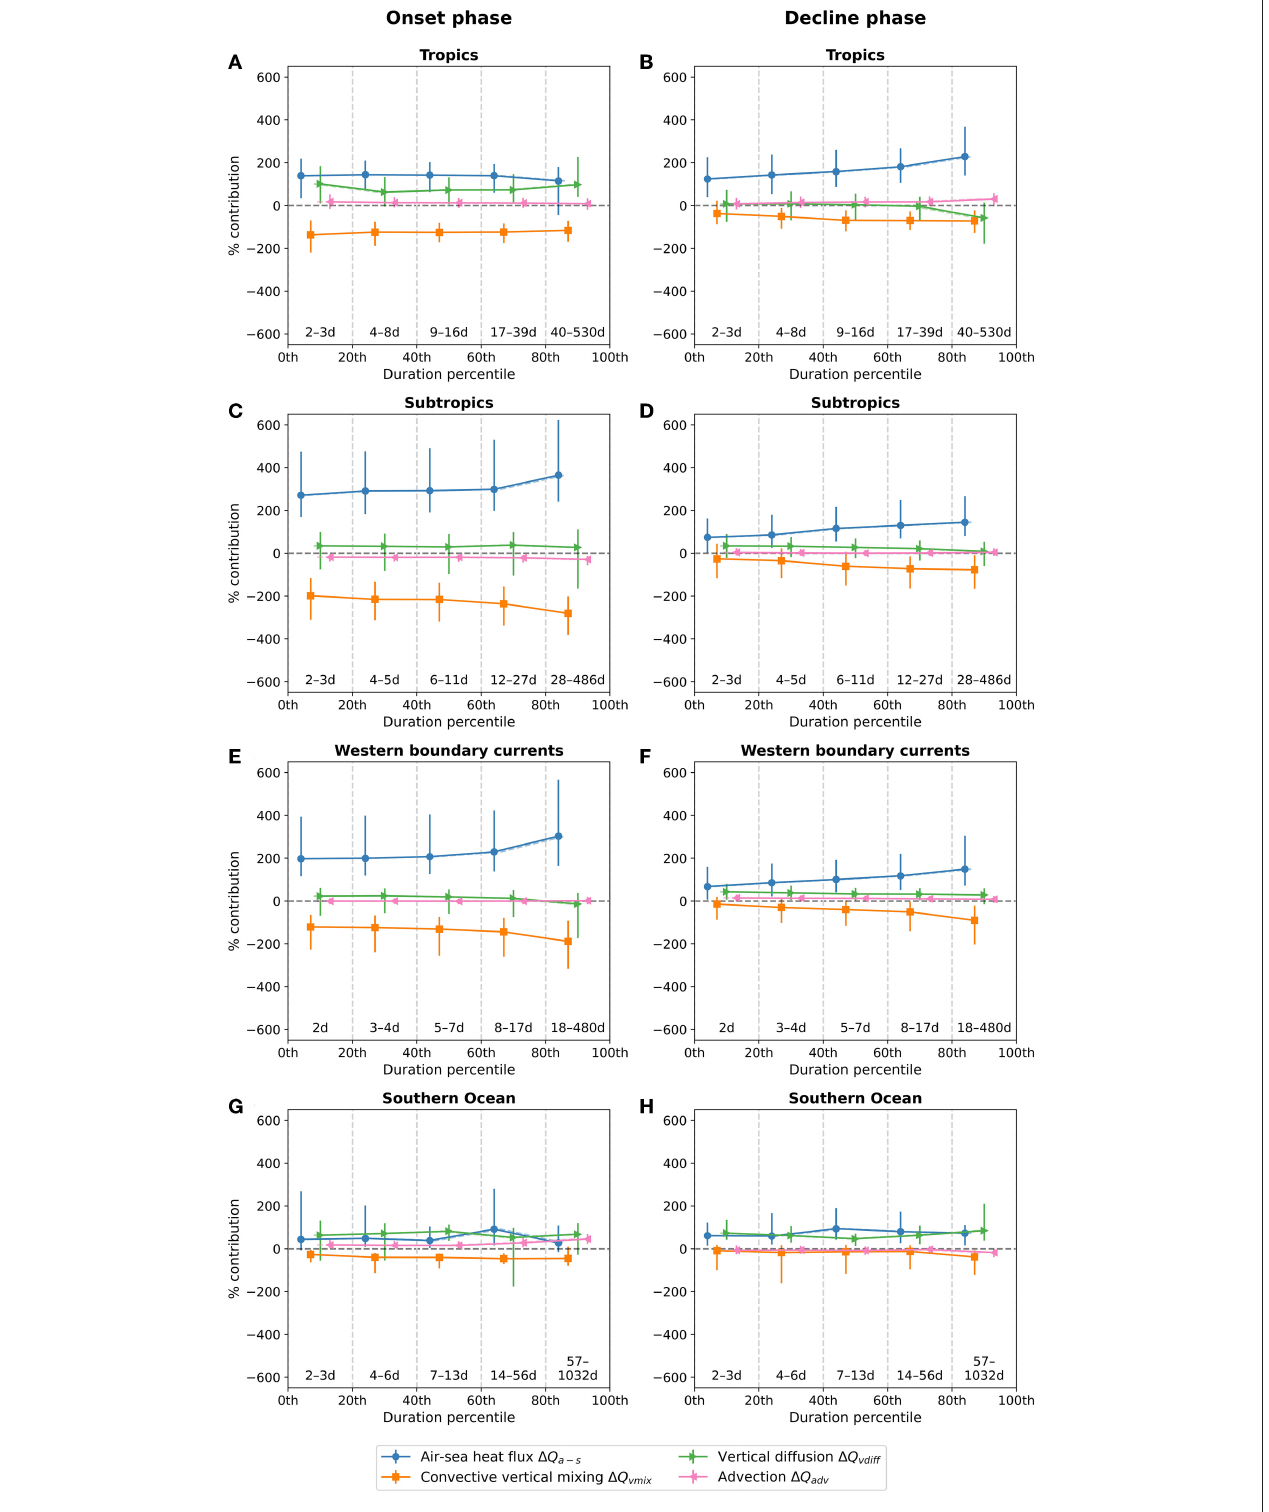
FIGURE 7 | The dependence of the marine heatwave drivers on the duration of marine heatwaves in four selected regions. The panels show the percentage contribution of marine heatwave drivers to the full temperature tendency during the onset and decline phases for different durations (start-to-end) of marine heatwaves in the tropics (A,B) , subtropics (C,D) , western boundary currents (E,F) , and Southern Ocean (G,H) . Each point gives the median percentage contribution of a driver to the total temperature anomaly during marine heatwaves with a duration within 10 percentage points of the duration percentile indicated on the x -axis. The vertical error bars show the interquartile range. For visual clarity, points within each duration bin are separated by a small horizontal distance. The regions are defined in Figure 8 .